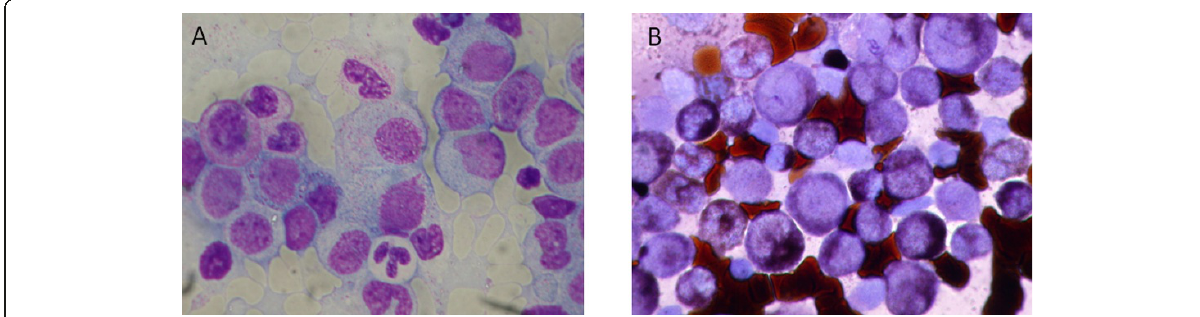
Figure 2 Bone marrow aspiration smear. A . myeloblasts accounting for 36.7% of nucleated cells. B . all leukemic cells positive for